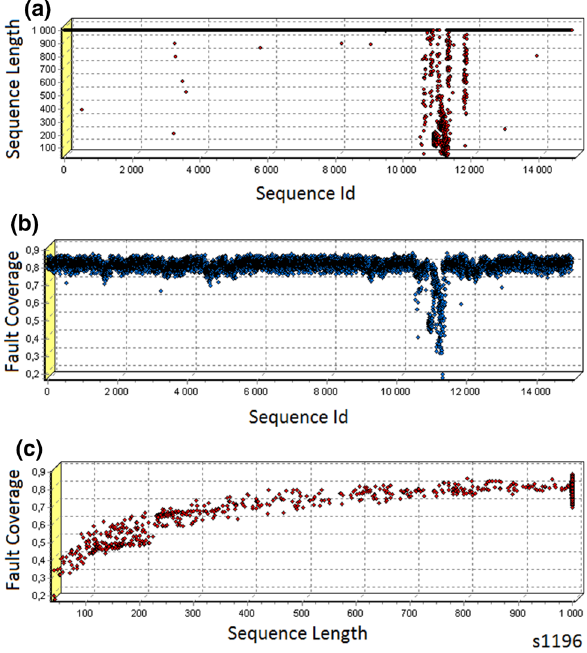
Fig. 16 Simulation graph for s1196 a sequence length vs. sequence id, b FC vs. sequence id and c FC vs. sequence length. STP (Id 1–7500),